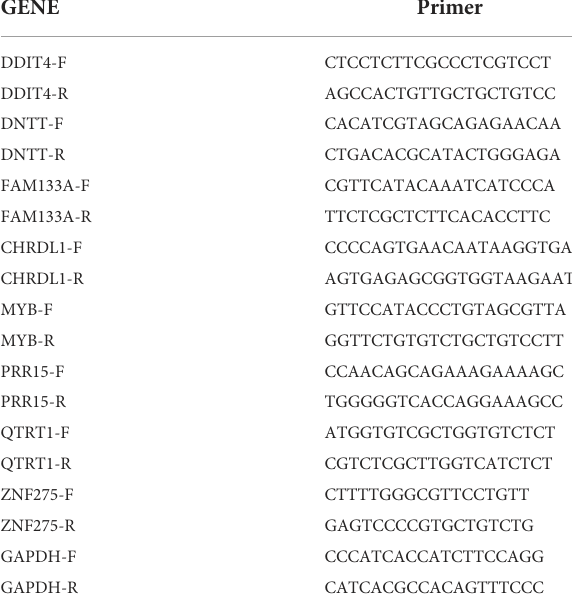
TABLE 1 Primers for 8 candidate hypoxia-immune related genes and Gapdh.